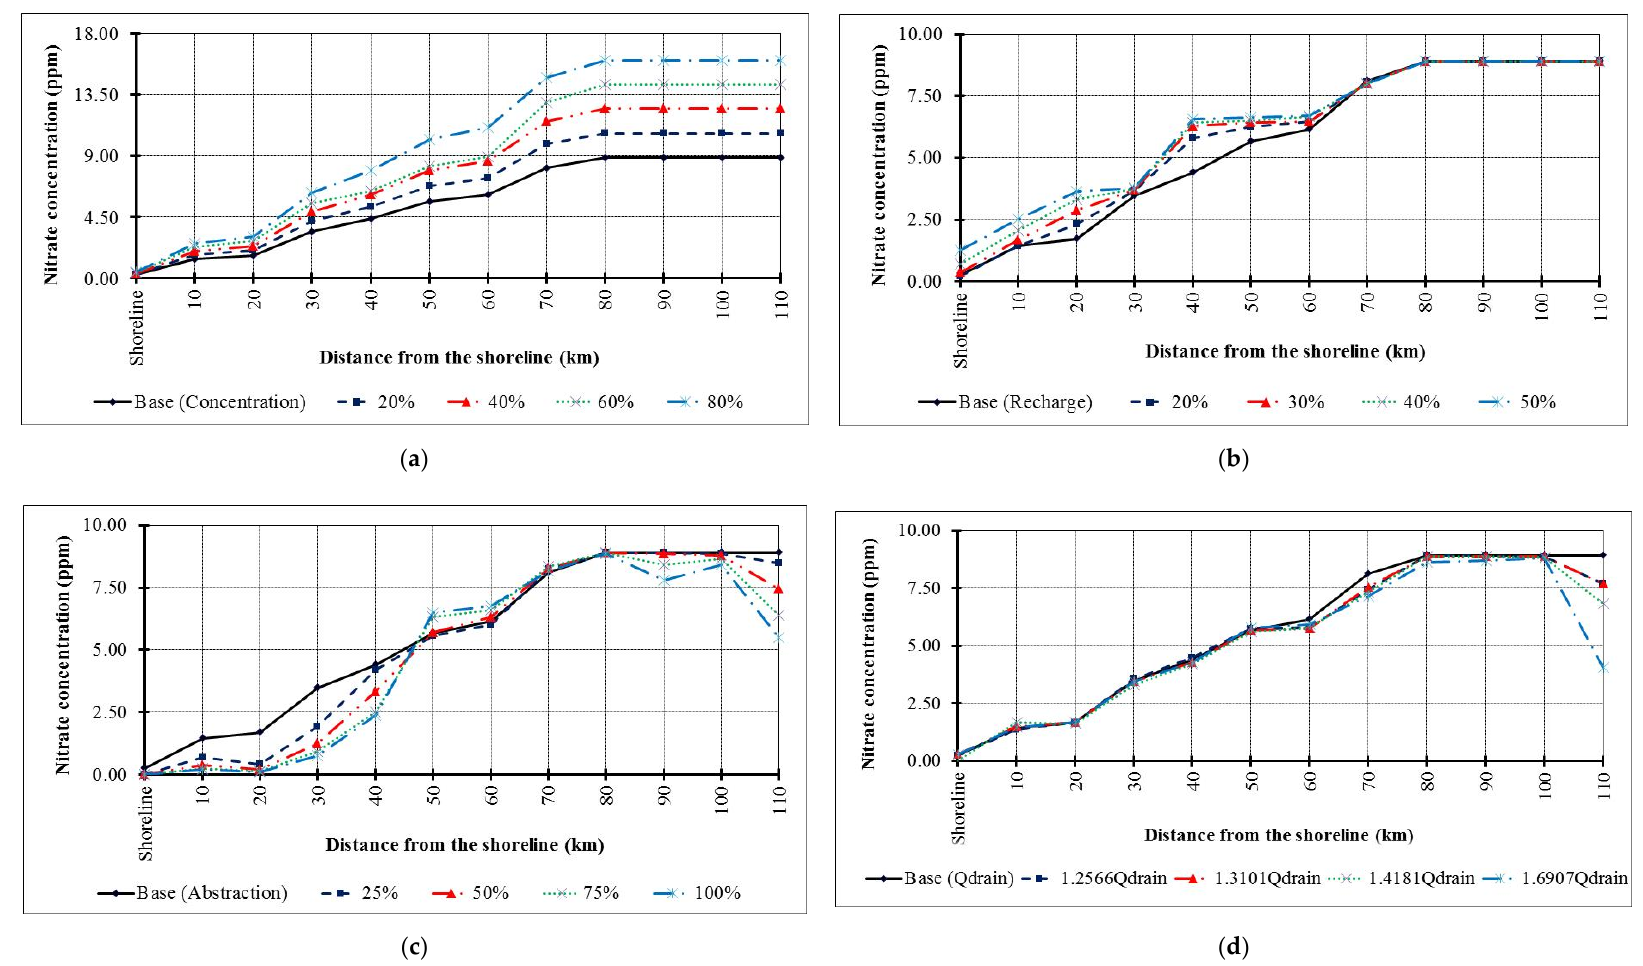
Figure 9. Simulated fertilizer concentration (ppm) at different distances from the shoreline for ( a ) extensive use of fertilizer (scenario 1), ( b ) recharge by rice cultivation (scenario 2), ( c ) over pumping (scenario 3), and ( d ) increased drainage network discharge (scenario 4).